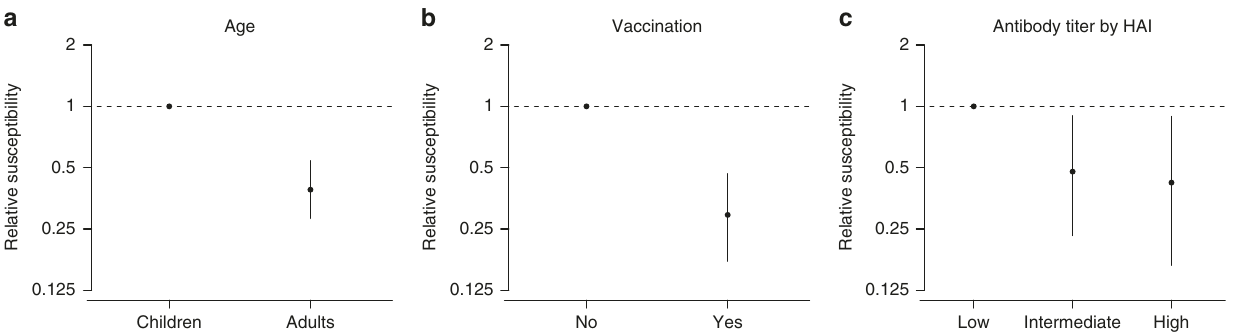
Fig. 3 Factors affecting the probability of infection. Point and line indicates the point estimate and the 95% credible interval of the relative susceptibility, respectively. 95% credible intervals are constructed by using MCMC to fi t the data with digraph model. a Estimated relative susceptibility of age. b Estimated relative susceptibility of vaccinees. c Estimated susceptibility of contacts with intermediate (20 or 40) and high ( > 40) level of pre-season antibody titers, compared with contacts with low ( < 20) level of pre-season antibody titers measured by the hemagglutination inhibition